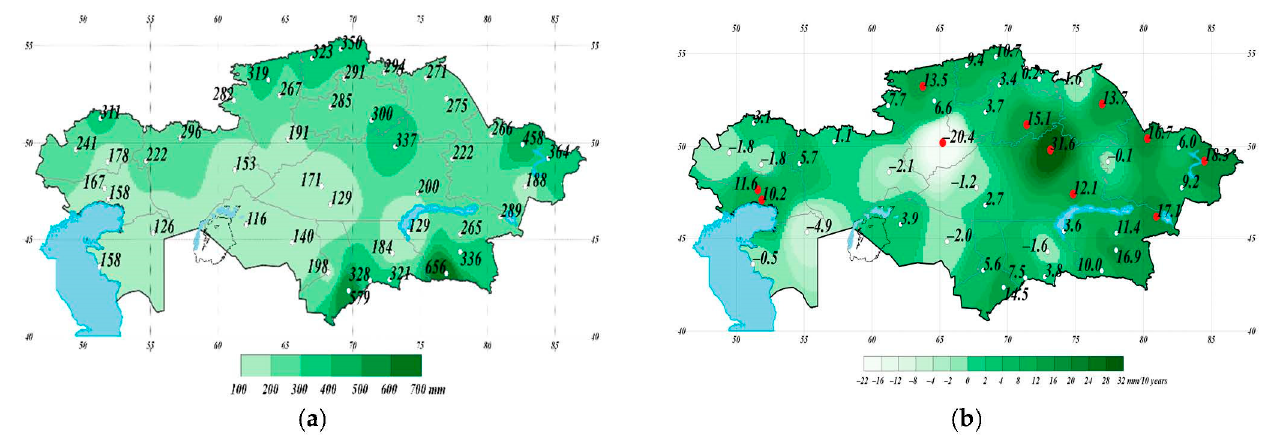
Figure 11. Spatial distribution of the index characterizing the annual precipitation sum index (PRCPTOT) ( a ) and trends ( b ) of this parameter for the period 1971–2020.